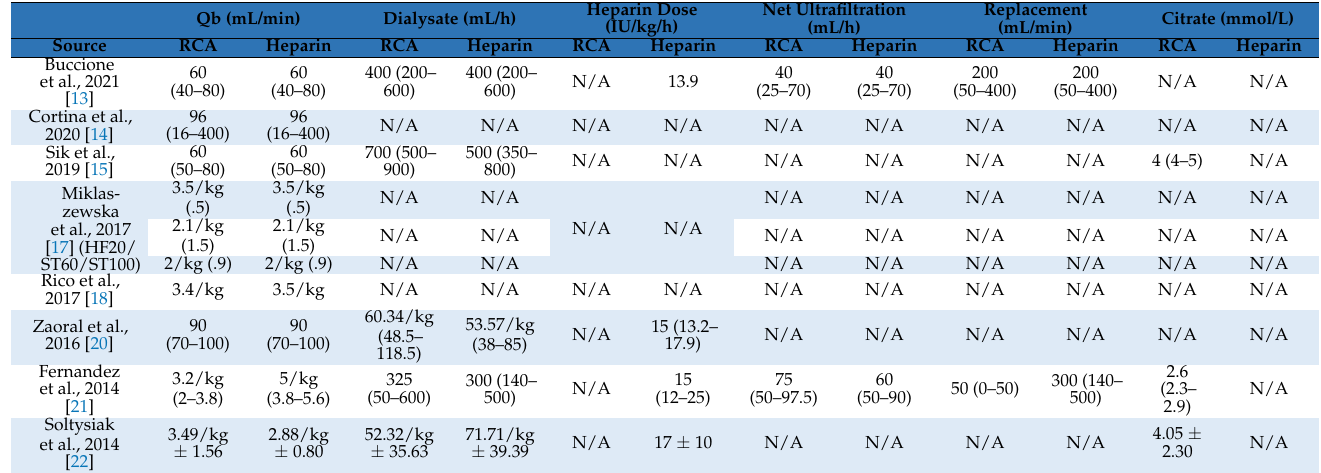
Table 7. Dialysis targets. RCA: regional citrate anticoagulation; Qb: blood pump